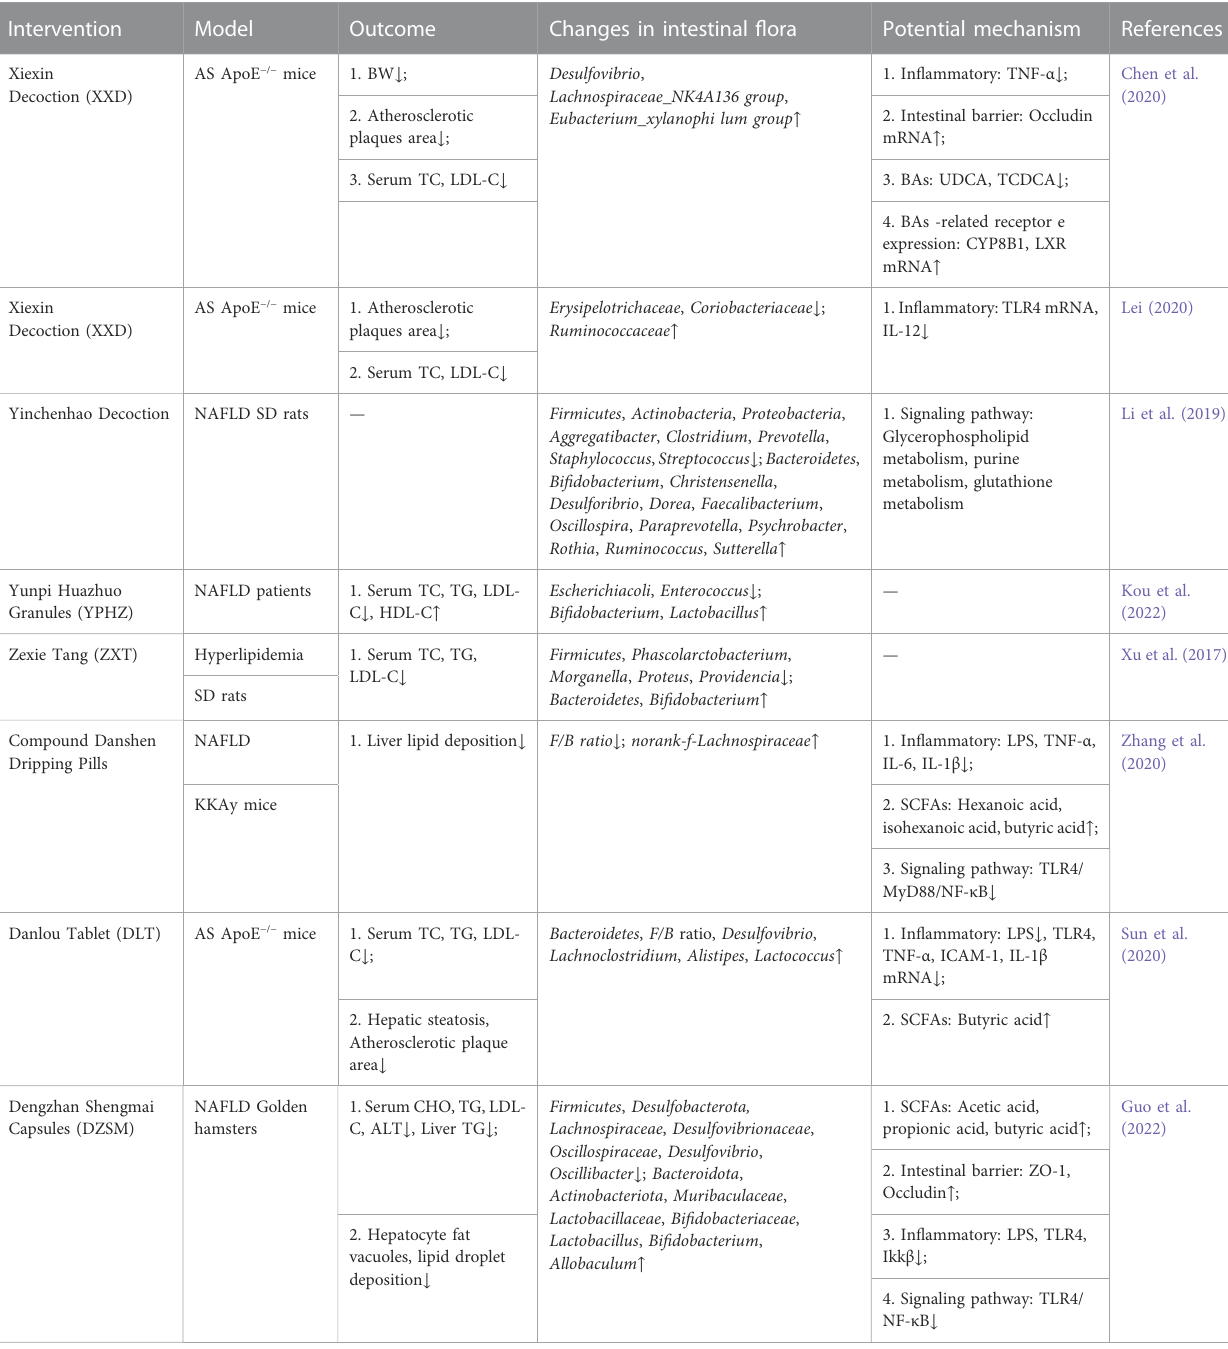
TABLE 1 ( Continued ) Therapeutic effects of Chinese herbal formulas and proprietary Chinese medicines on